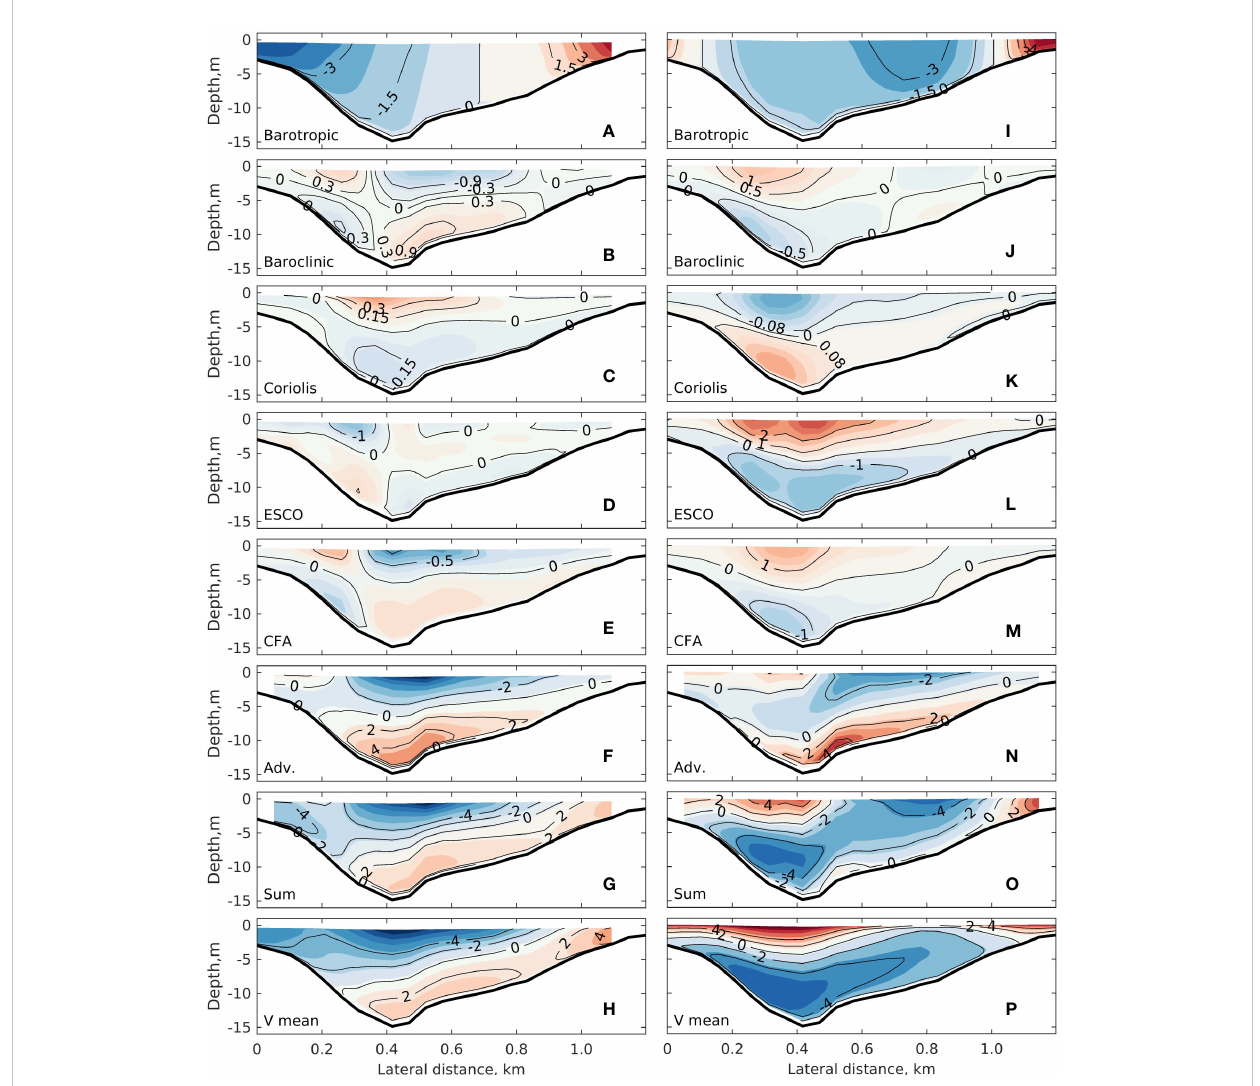
FIGURE 7 Transverse distributions of the across-channel residual fl ow due to individual terms of the subtidal lateral momentum balance during (left column) neap tide and (right column) spring tide: (A, I) barotropic fl ow ( v Baro ), (B, J) baroclinic (density-driven) fl ow ( v D ), (C, K) fl ow due to Coriolis de fl ection ( v C ), (D, L) ESCO induced fl ow ( v ESCO ), (E, M) CFA induced fl ow,V CFA and (F, N) nonlinear advection ( v ADV ). Panels (G, O) are the summation of the above terms. Panels (H, P) show the tidal mean velocity. Positive values indicate rightward fl ow. The unit in all contours is cm s − 1